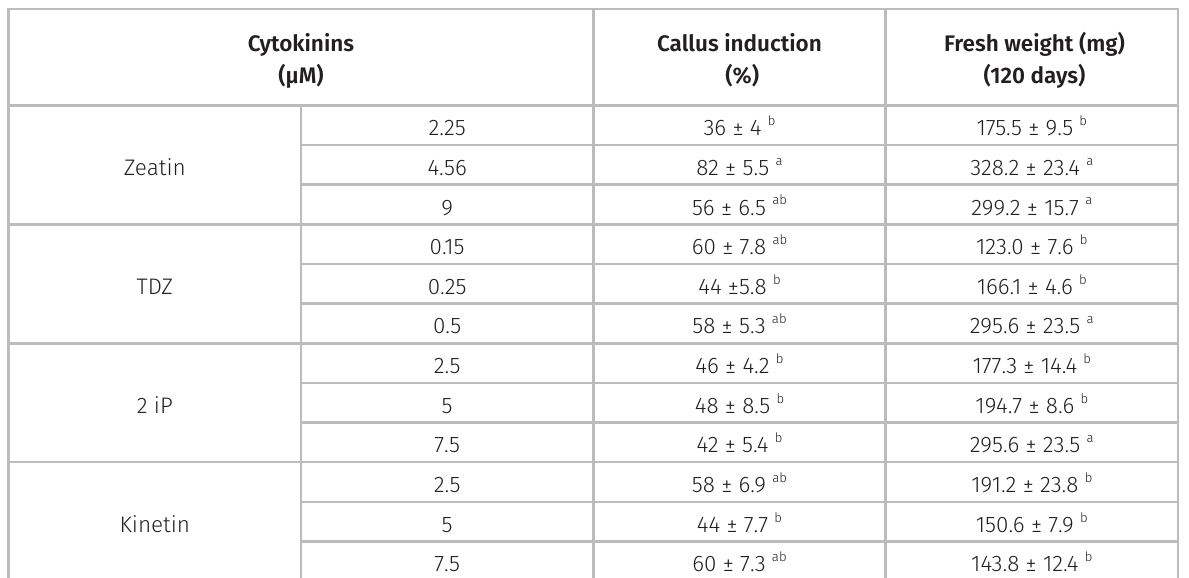
Table I. Effects of cytokinin type and concentrations on callus induction and calli fresh weight in callus culture from I. paraguariensis (clone 6-156-6) leaf